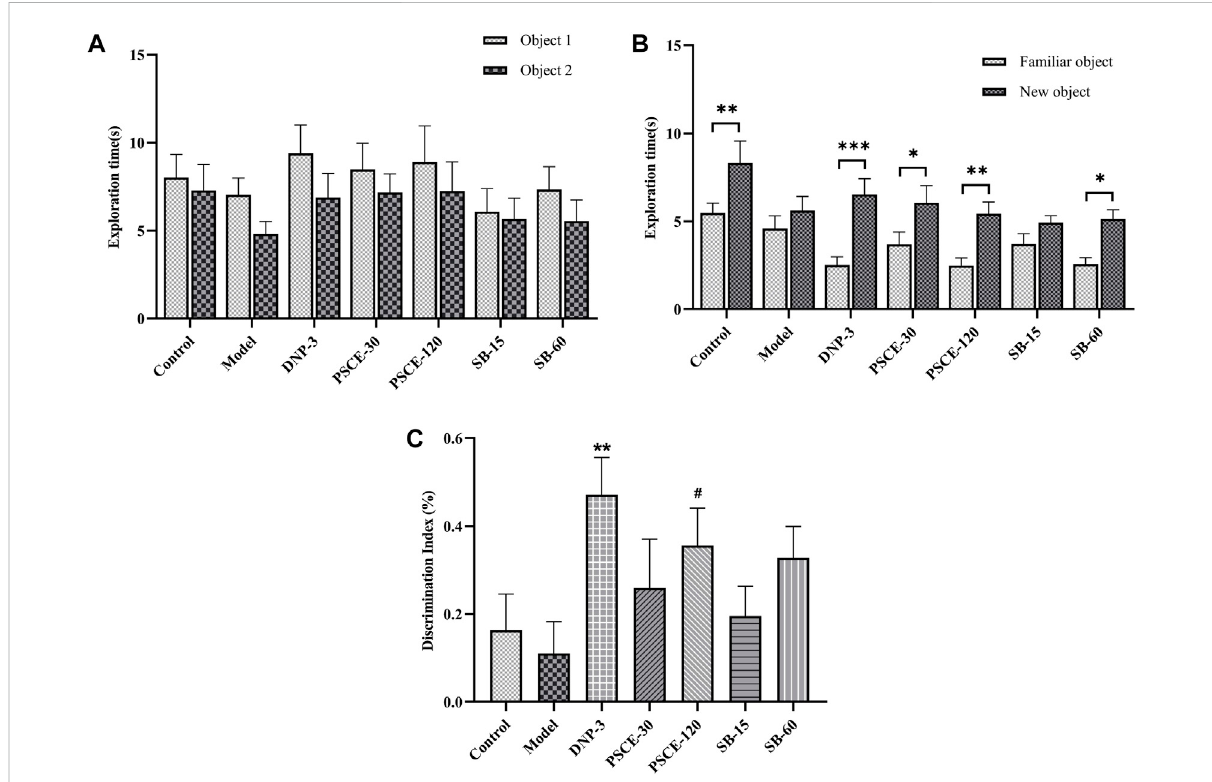
FIGURE 7 Effects of PSCE and SB on scopolamine-induced mice in NOR. (A) the exploration time of two objects in the familiarity period. (B) the exploration time of familiar and new objects in the test period. (C) the relative discrimination index (DI) in the test period. Experimental data were expressed by Means ± SEM (n = 9 – 13 per group). Compared with the exploration time of the old object, * p < 0.05, ** p < 0.01, *** p <